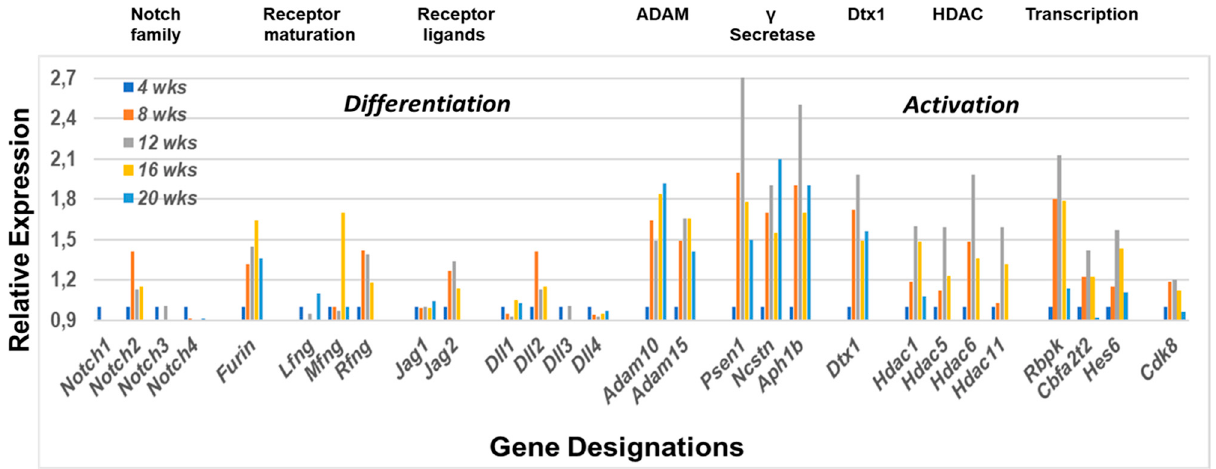
Figure 2. Prolonged upregulated activation of the Notch2 signal transduction pathway in the salivary glands prior to onset of the adaptive response. Notch2 is a transmembrane protein receptor whose extracellular portion is post-translationally modified in the Golgi bodies by furin and fringe molecules (i.e., Lfng, Mfng or Rfng) prior to insertion into the cellular membrane, enhancing subsequent MZB cell functions. On activation by a Notch2 ligand (i.e., Jagged or Delta), the Notch2 molecule undergoes sequential cleavage first by Adam10 and then by γ -secretase, thereby releasing the cytoplasmic protein Dtx (an E3 ubiquitin ligase), as well as the Notch intracellular domain (NICD) that gets transported to the nucleus. In the nucleus, NICD displaces corepressors, including HDAC (histone deacetylase complex), permitting direct interaction with Rbpk to activate Hes, thus driving Notch2-regulated gene transcription. Downregulation of the Notch2 pathway occurs through phosphorylation of NCID by Cdk8 that initiates polyubiquitination and proteasome degradation. In this model, however, while the Notch2 pathway remains activated, Cdk8 exhibits, at best, minimum upregulated expression, suggesting the MZB cells may persist and over time differentiate from their effector function to their APC function for invoking the adaptive response. Gene symbols and gene descriptions are: Notch (notch gene homolog ( Drosophila )); Furin (paired basic amino acid-cleaving enzyme); Lfng (LFNG O-fucosylpeptide 3-beta-acetylglucosaminyltransferase); Mfgn (MFNG O-fucosylpeptide 3-beta- N -acetylglucosaminyltransferase); Rfng (RFNG O-fucosylpeptide 3-beta-acetylglucosaminyltransferase); Jag1 (jagged 1); Jag2 (jagged 2); Dll1 (delta-canonical Notch ligand/delta-like 1 homolog); Dll2 (delta-canonical Notch ligand/delta-like 2 homolog); Dll3 (delta-canonical Notch ligand/delta-like 3 homolog); Dll4 (delta-canonical Notch ligand/delta-like 4 homolog); Adam10 (a disintegrin and metallopeptidase domain 10); Adam15 (a disinteg- rin and metallopeptidase domain 15); Psen1 (Presenilin 1); Ncstn (nicastrin); Aph1b (aph-1 homolog B, gamma-secretase);